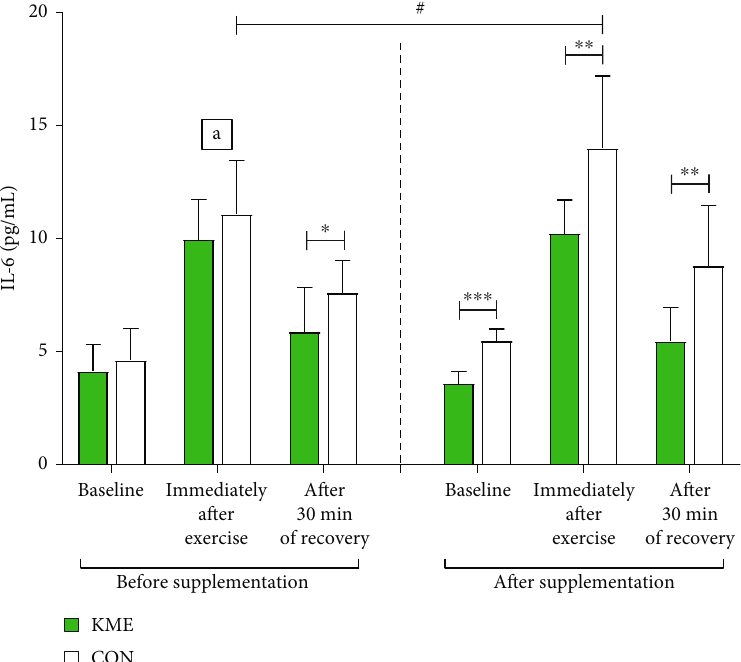
Figure 3: Changes in interleukin-6 levels during the 2,000 m rowing ergometer exercise trials performed before and after supplementation ( means ± SD ). a Interaction e ff ects immediately after exercise. # p < 0 : 05 before vs. after; ∗ p < 0 : 05 , ∗∗ p < 0 : 01 , and ∗∗∗ p < 0 : 001 KME vs.